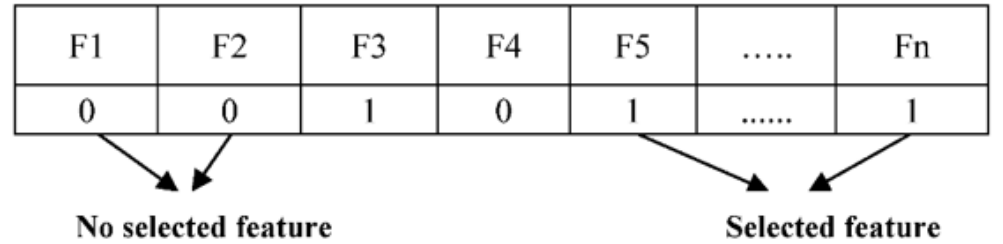
Figure 1. A representation of the features in BDA (Qasim and Algamal,